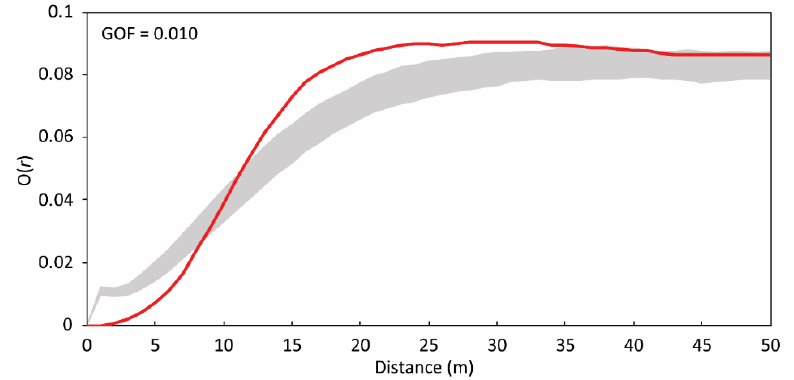
Figure 6. Gap size-frequency distribution of canopy gaps identified from a LiDAR-derived canopy height model. Canopy gap size bins are 25 m 2 size classes. Note our maximum gap size threshold was 300 m 2 .